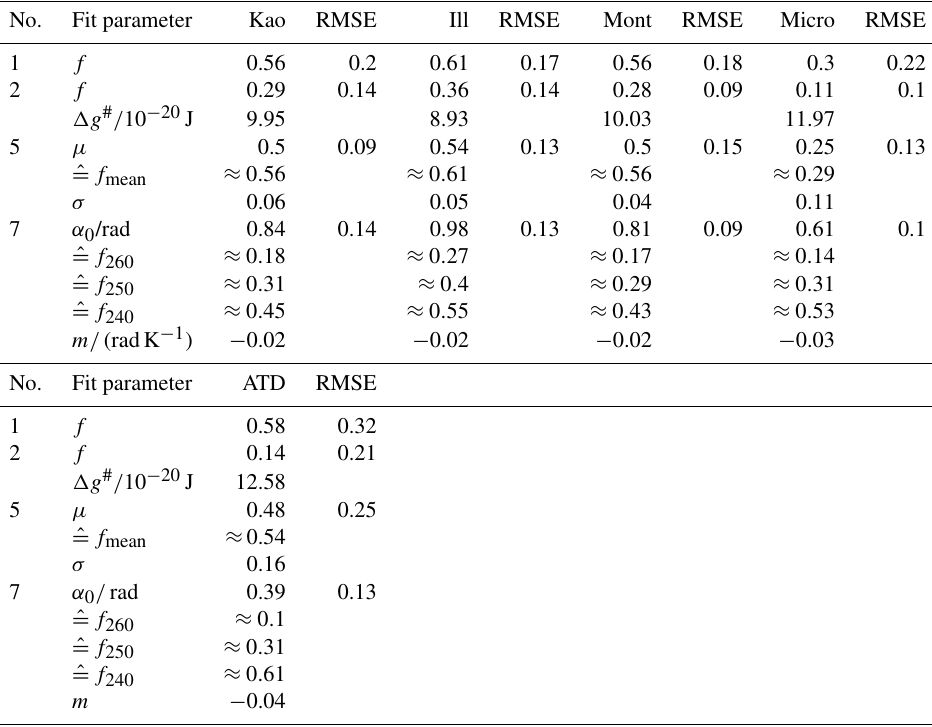
Table 2. Derived fit parameters for the different CNT formulations and five different mineral dust types (kaolinite (kao), illite (ill), montmo- rillonite (mont), microcline (micro), ATD). The values are rounded to two digits after the decimal point. The logarithmic mean contact angle µ and the temperature-dependent contact angles are converted into the geometric term f using Eq. (3).